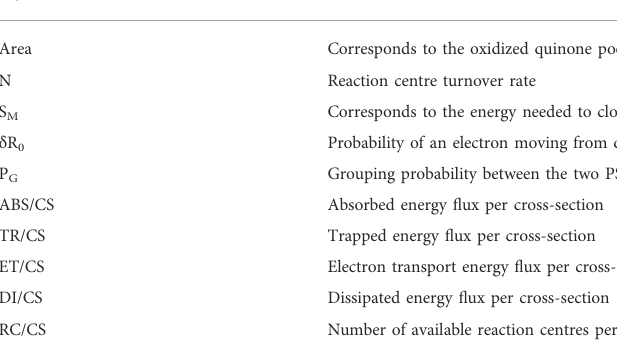
TABLE 1 Fluorometric analysis parameters and their description.